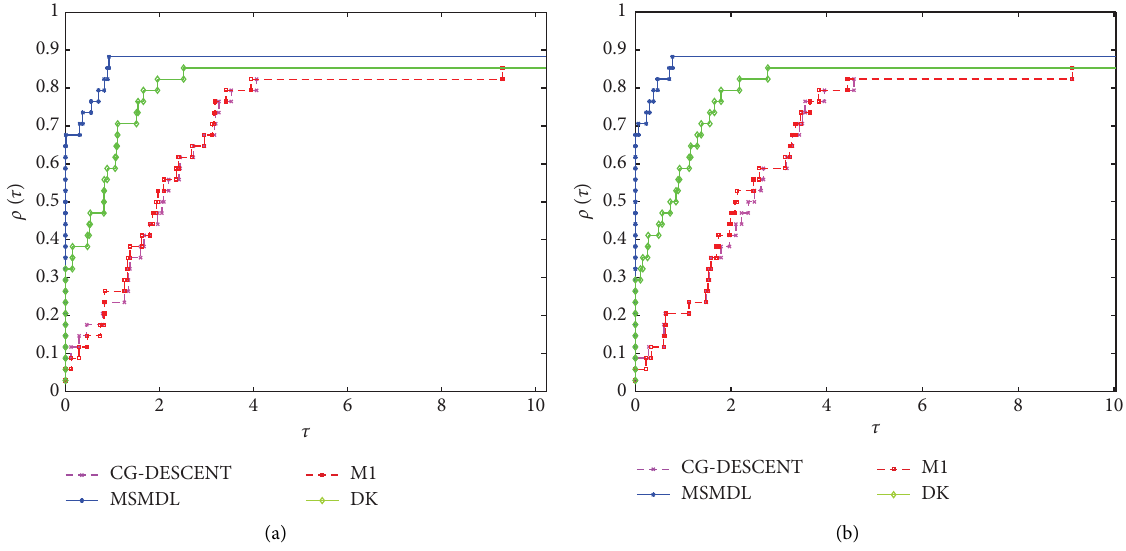
Figure 2: (a) NI and (b) NFE performance profles for MSMDL, M1, CG-DESCENT, and DK.